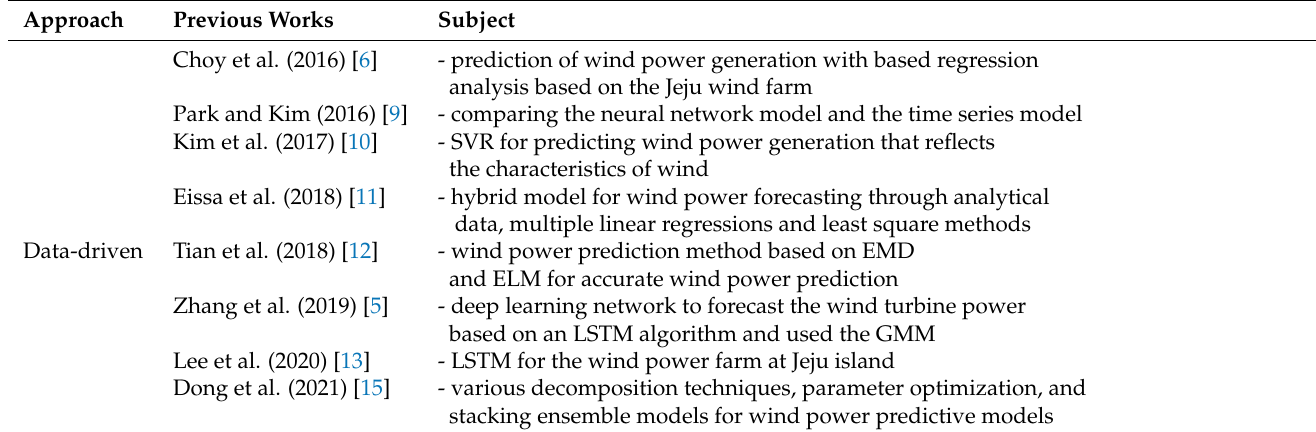
Table 1. Previous WPF works (data driven and transfer learning